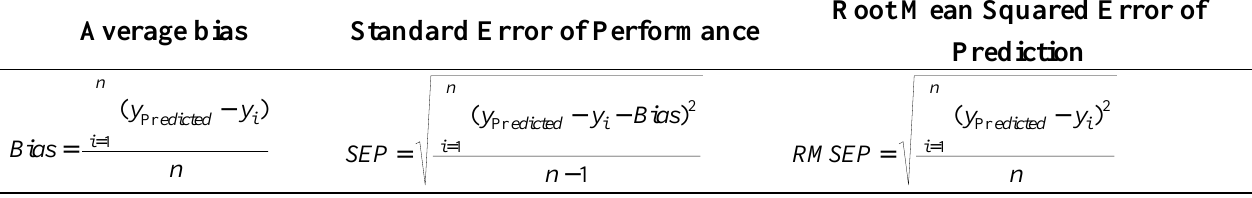
Figure 4. Modelling vapour pressures of organic compounds from their chemical (UNIFAC) structure. 147 randomly sampled compounds were used as training set. The remaining 147 compounds were used as test set. The modelling was repeated with test set as training set and training set as test sat. The models were made by multivariate PLS regression of vapour pressures on chemical (UNIFAC) structure of the